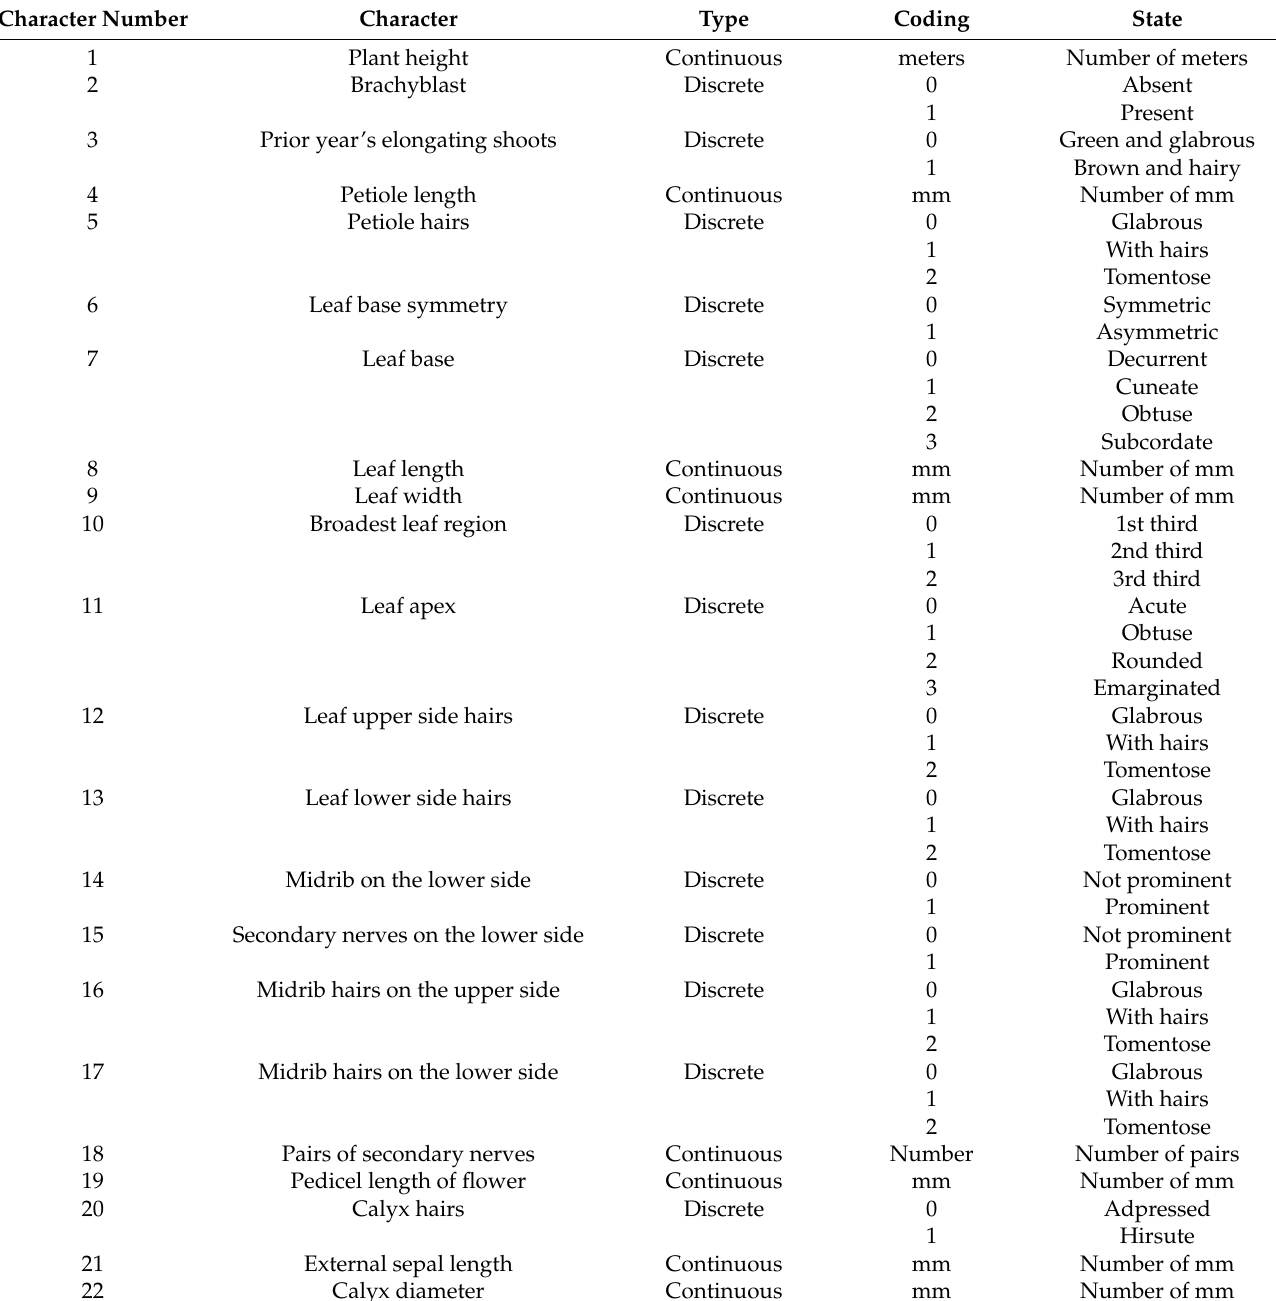
Table 3. Characters used for the principal coordinate analysis with 123 specimens of the Capurodendron Arid